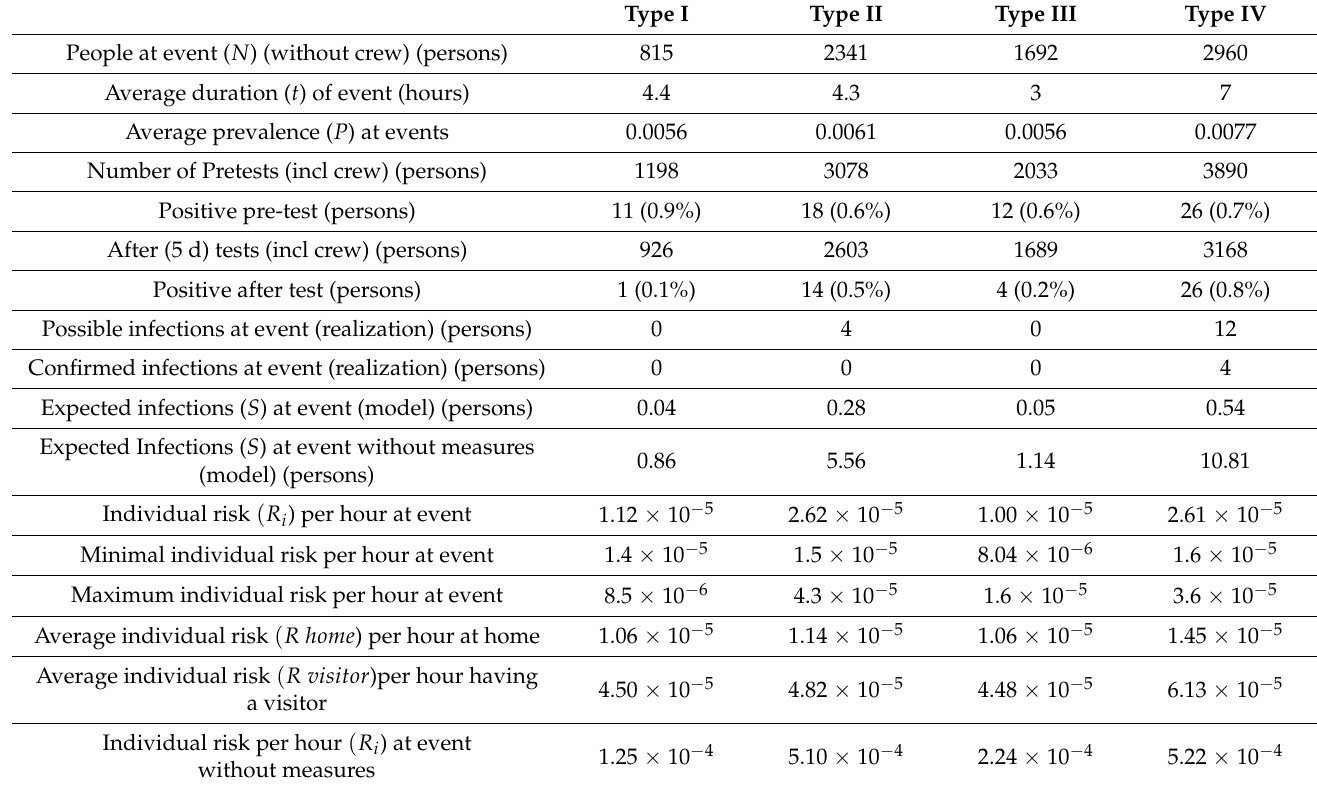
Table 4. Comparison model results with realization at test events of type i